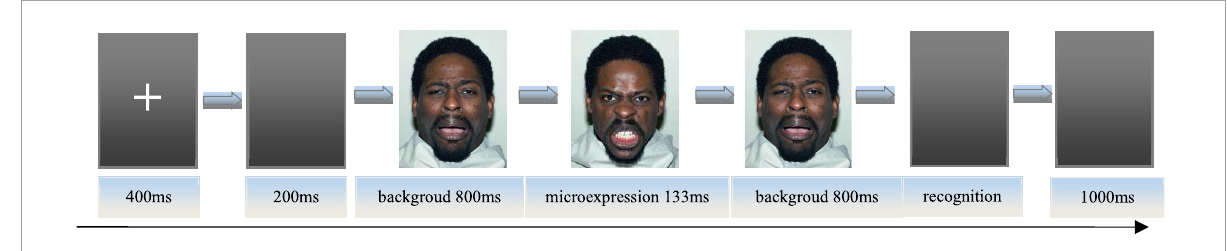
FIGURE1 The picture of the experiment procedure from Zhang et al. (2020b). These images are licensed by the copyright owners, Tottenham et al. (2009) and Zhang et al. (2020b).